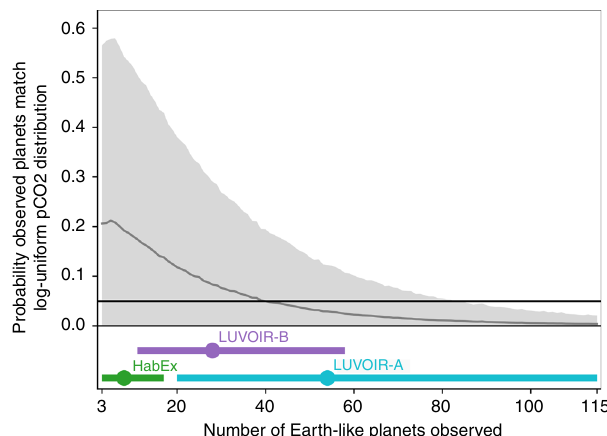
Fig. 3 The probability observed exoplanets will accidentally match a log- uniform distribution for pCO 2 in the HZ if the true pCO 2 distribution is regulated by the carbonate – silicate weathering cycle, as shown in Fig. 1. This probability is shown on the vertical axis. The horizontal axis shows the number of observed Earth-like exoplanets. The solid gray curve and corresponding shaded gray region show the mean probability and 2 σ uncertainty, respectively, that the observed planets, sampled from the planets shown in Fig. 1, match a log-uniform pCO 2 distribution in the HZ. This curve is calculated from 10,000 two-dimensional Kolmogorov – Smirnov tests (see Results, subsection “ Observational uncertainty for pCO 2 in the HZ ” ). The solid, horizontal black line highlights the 5% probability line. At the bottom of the fi gure, the labeled points and error bars show the number of Earth-like exoplanets the next generation of proposed space telescopes are expected to observe (telescope data in Table 2). The vertical scaling of the telescope points is arbitrary, only the horizontal position and extent of the 1 σ error bars is signi fi cant. To rule out a log-uniform pCO 2 distribution with 95% con fi dence, future telescopes would need to observe at least 83 Earth-like